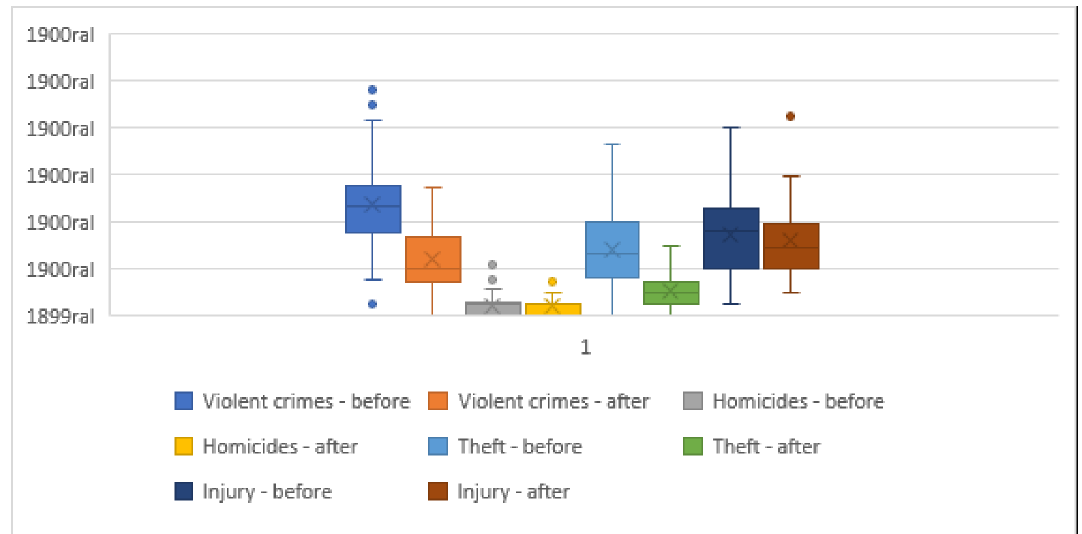
Figure 15: Boxplot for all the Brumadinho dataset Source: Occurrences: Armazém Sisp (official data warehouse for Minas Gerais state public security system). Demographic data: IBGE.